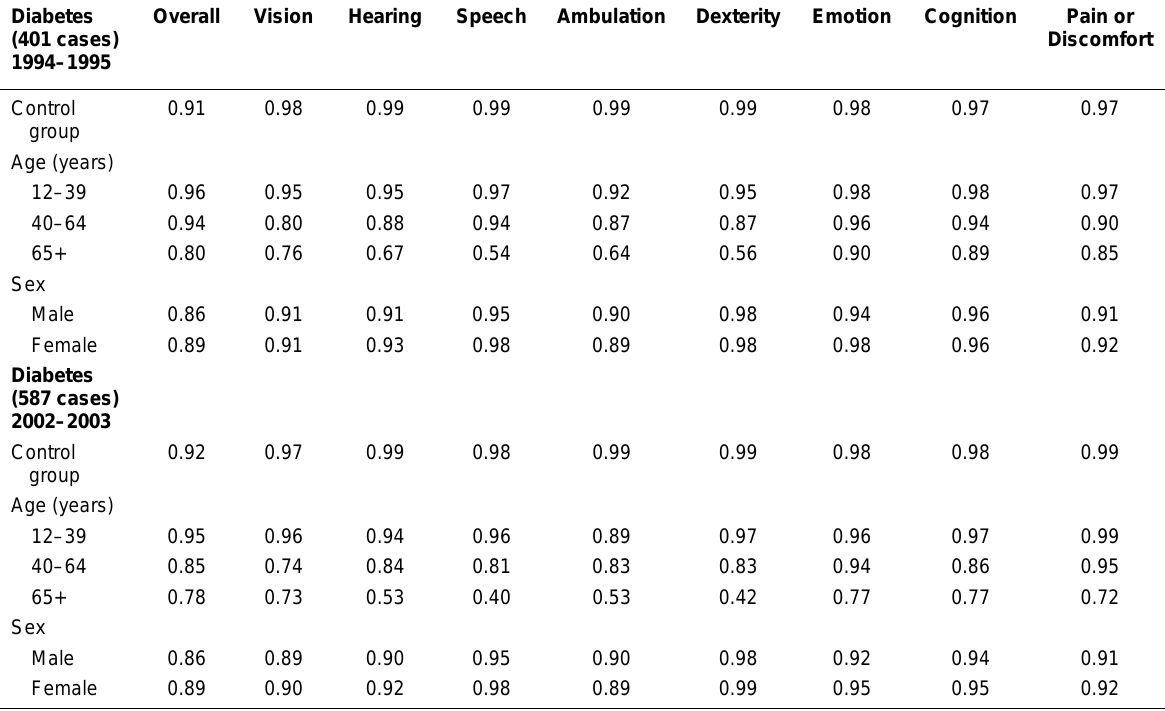
Adjusted Mean of Overall HUI3 and Single-Attribute Scores Related to Diabetes by Age and Sex, NPHS Longitudinal Data, from 1994–2003